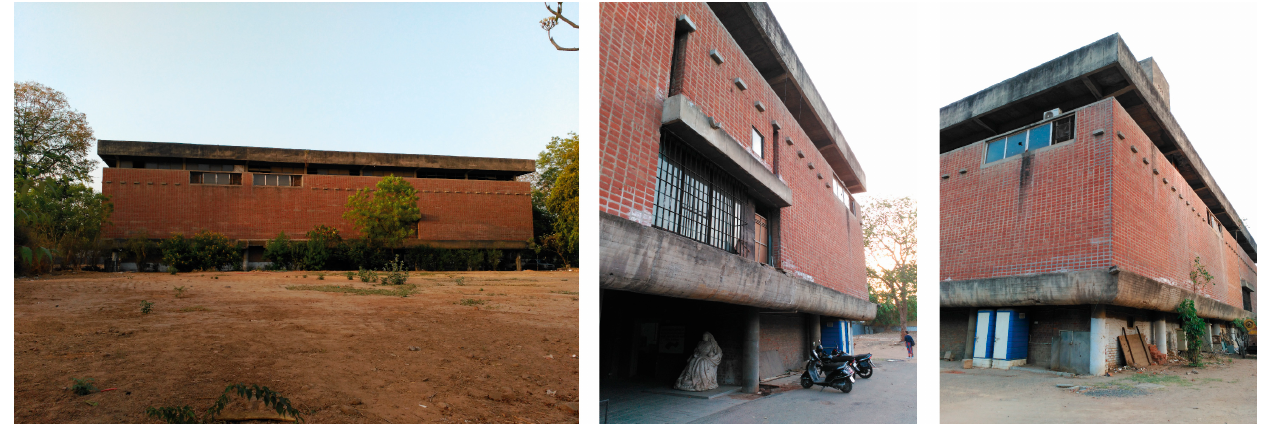
Figure 2. Ahmedabad Museum (India, built in 1951) abandoned and degraded. Source: Authors.